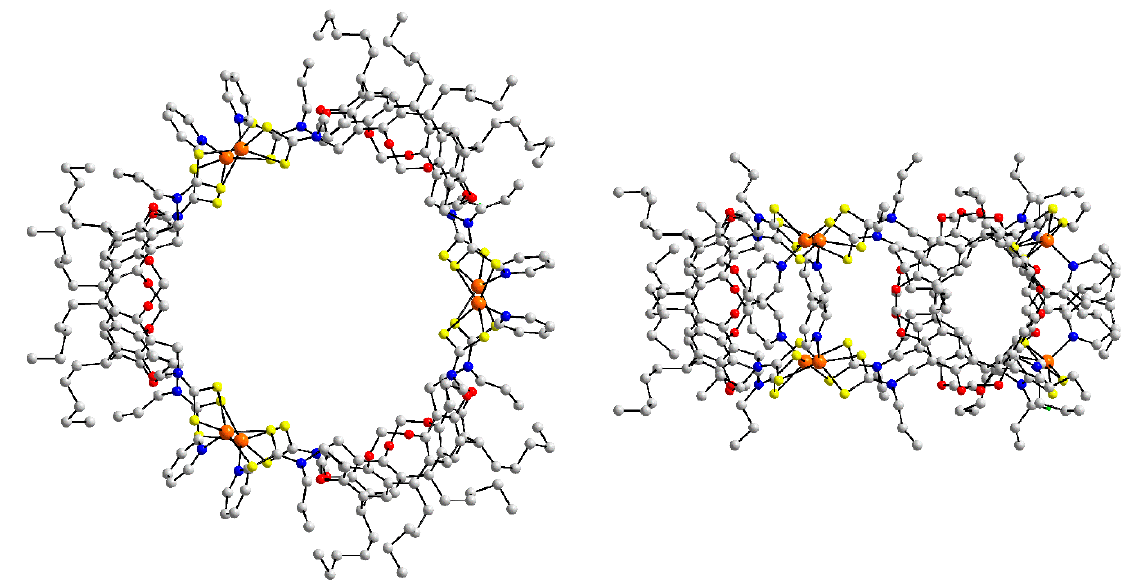
Figure 12. Molecular structure of neutral Zn 6 (L 11 ) 3 in the crystal of 43 : plan and side-on views.